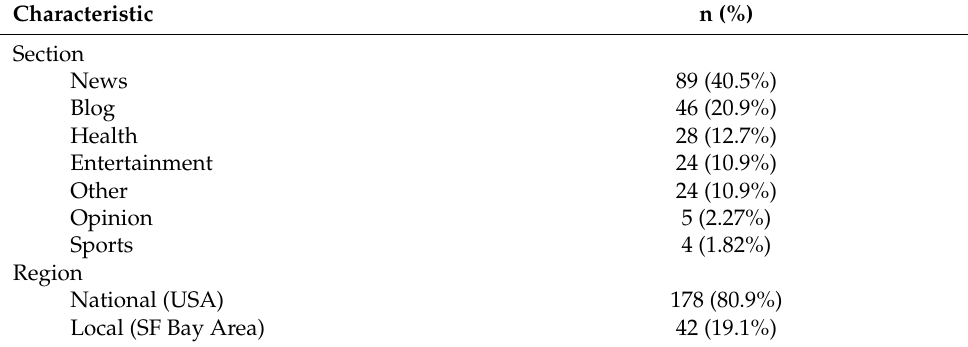
Figure 2. Surge in Articles Following Two High Profile Deaths by Suicide. Table 2. Article Characteristics.